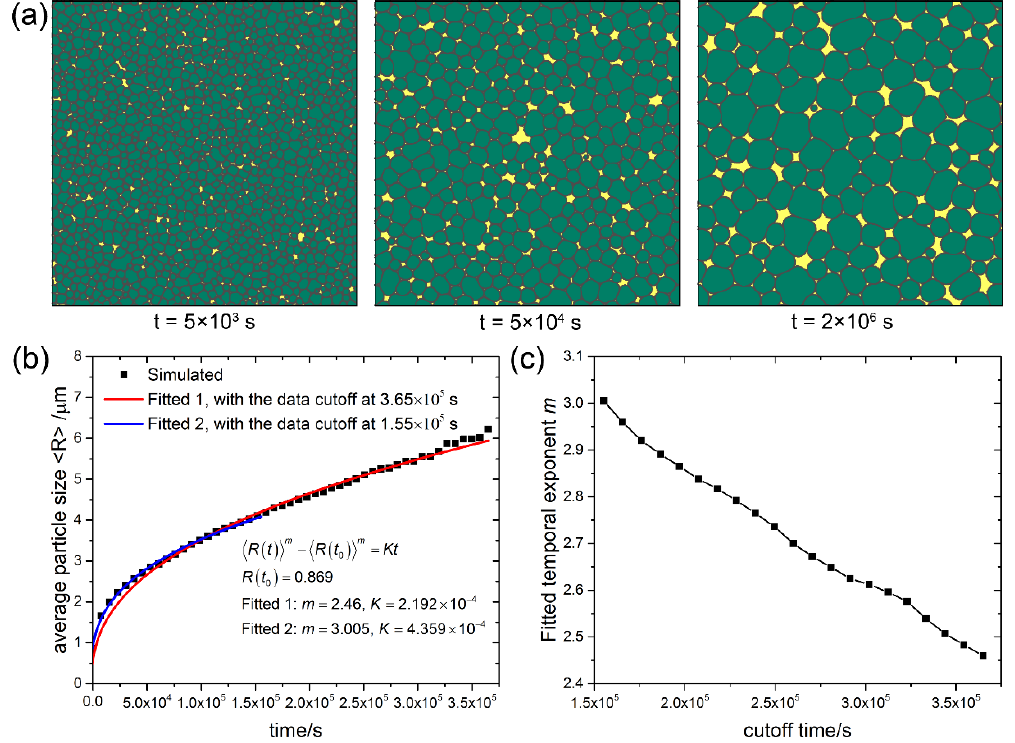
Figure 4. System with f v = 90%. ( a ) Microstructure evolution; ( b ) Average particle size vs. time; ( c ) Fitted temporal exponents m of the power law (cid:104) R ( t ) (cid:105) m − (cid:104) R ( t 0 ) (cid:105) m = Kt at different cutoff times. Simulation grid is 1000 × 1000 with the cell size of 0.1 μm.